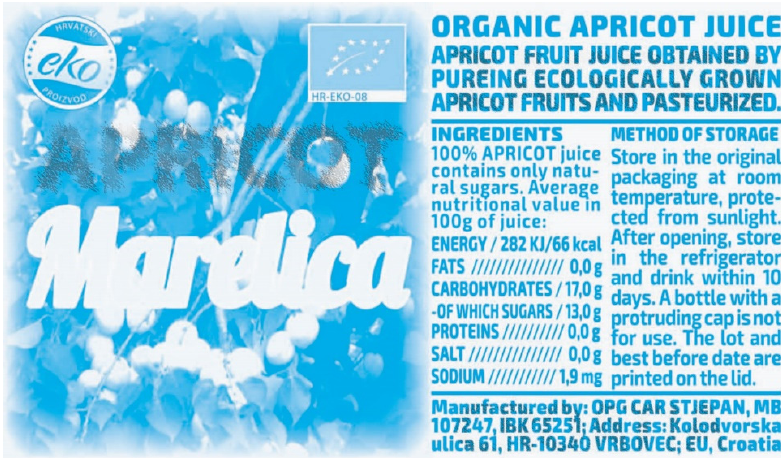
Figure 5. IRR photograph with a blockade at 700 nm.